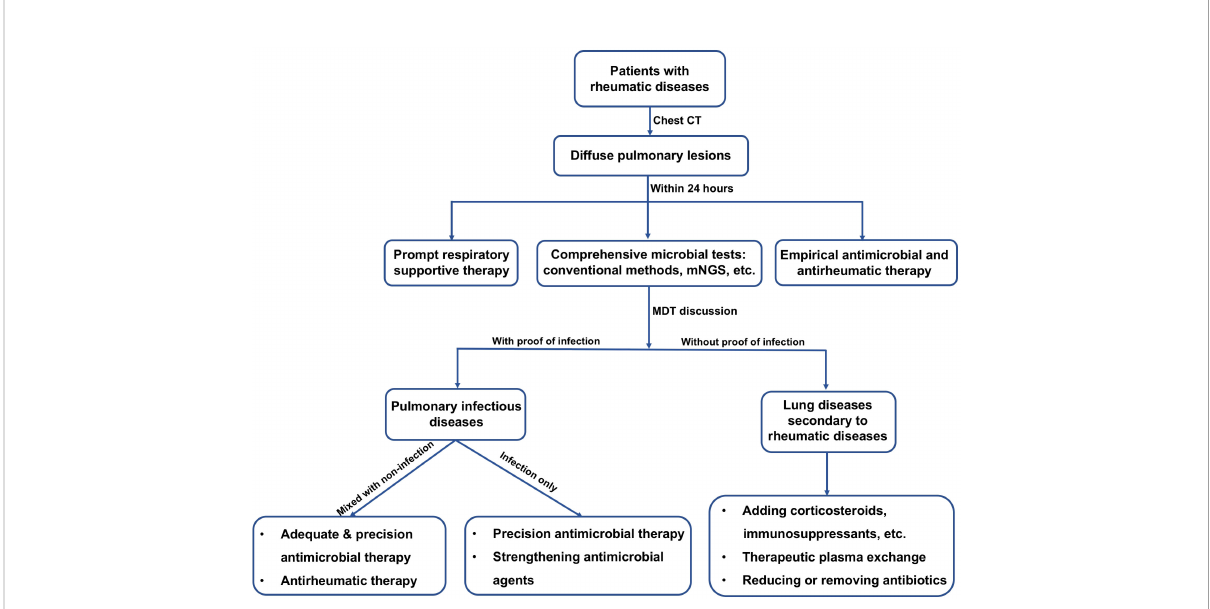
FIGURE 4 Flow-chart for suggested clinical management of patients diagnosed with rheumatic diseases and presenting diffuse pulmonary lesions. CT, computed tomography; mNGS, metagenomic next-generation sequencing; MDT, multidisciplinary team.